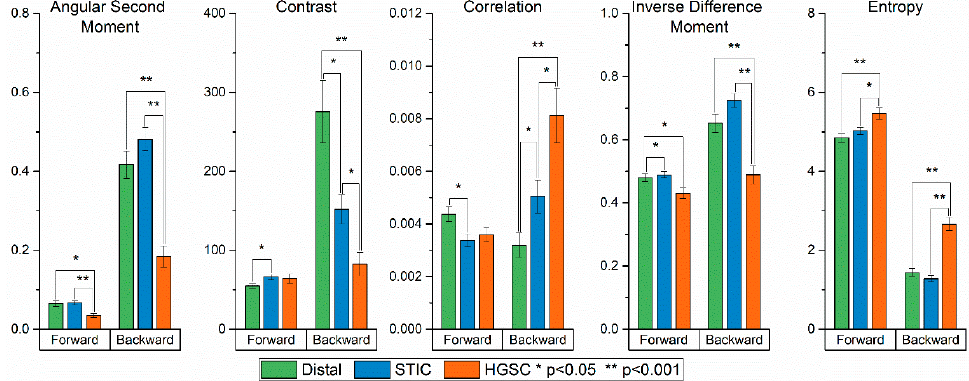
Figure 3. Bar plots of the mean value for each group in all five (forward and backward) of the textures < 0.05 and p < 0.001, calculated in the GLCM analysis. (*) and (**) correspond to p < 0.05 and p < 0.001, respectively. calculated in the GLCM analysis. (*) and (**) correspond to p